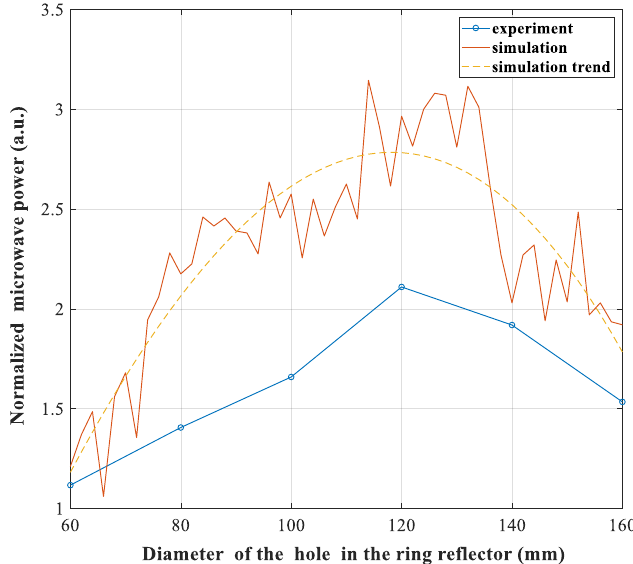
Figure 8. Normalized microwave power of the simulations and experiments as a function of the anode-to-ring-reflector distance.